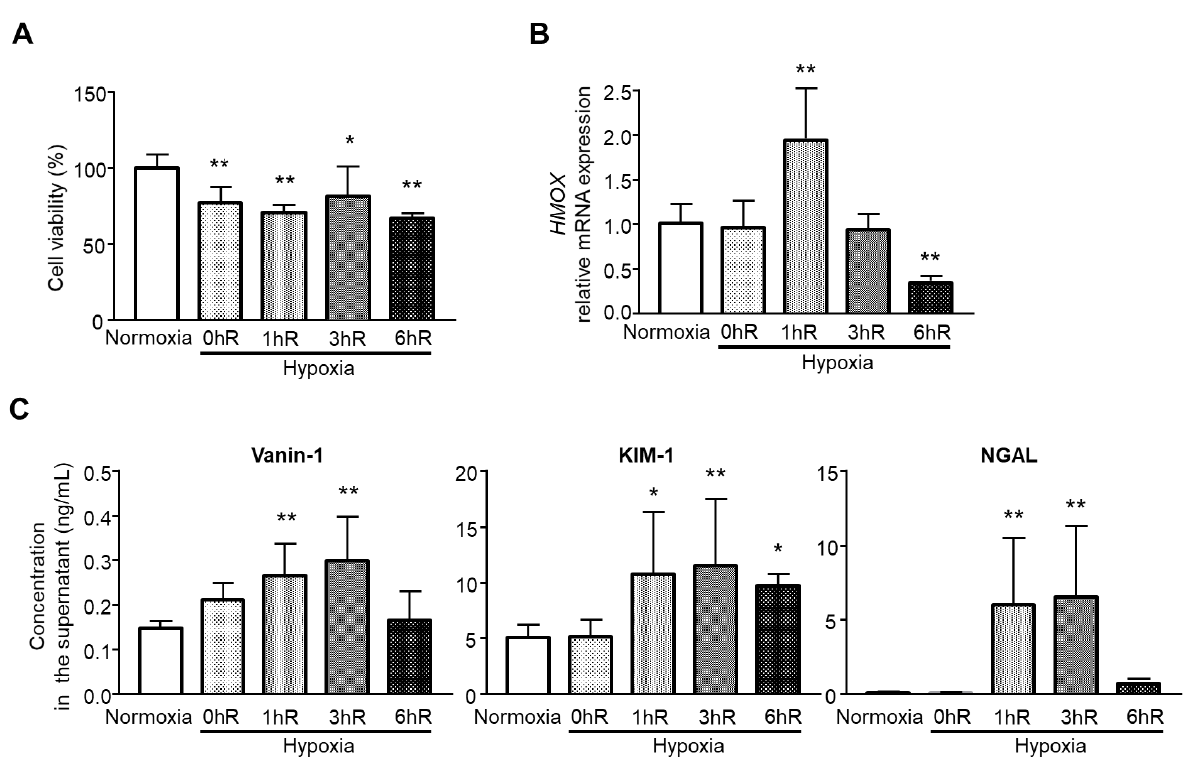
Figure 4. Effects of hypoxia reoxygenation on vanin-1, KIM-1, and NGAL in vitro. HK-2 cells were exposed to normoxia (control) or hypoxia for 24 h followed by reoxygenation for 0 h (0hR), 1 h (1hR), 3 h (3hR), or 6 h (6hR). ( A ) CCK8 assays were used to detect the cell viability of HK-2 cells under various conditions. ( B ) The mRNA level of heme oxygenase 1 ( HMOX1 ) was determined using real-time quantitative PCR. The mRNA expression level was normalized to that of GAPDH . ( C ) The supernatant from the cells ( n = 6 per group) was collected for measurement of vanin-1, KIM-1, or NGAL. HK-2, human immortalized tubular epithelial cells. * p < 0.05; ** p < 0.01 vs. normoxia.